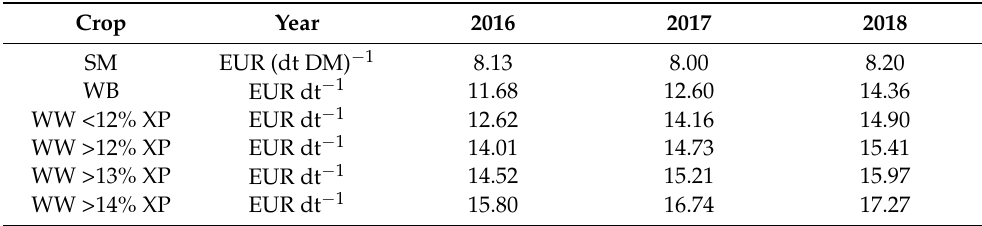
Table 5. Overview of postharvest prices in 2016 to 2018 for silage maize (SM), winter barley (WB), and winter wheat (WW).